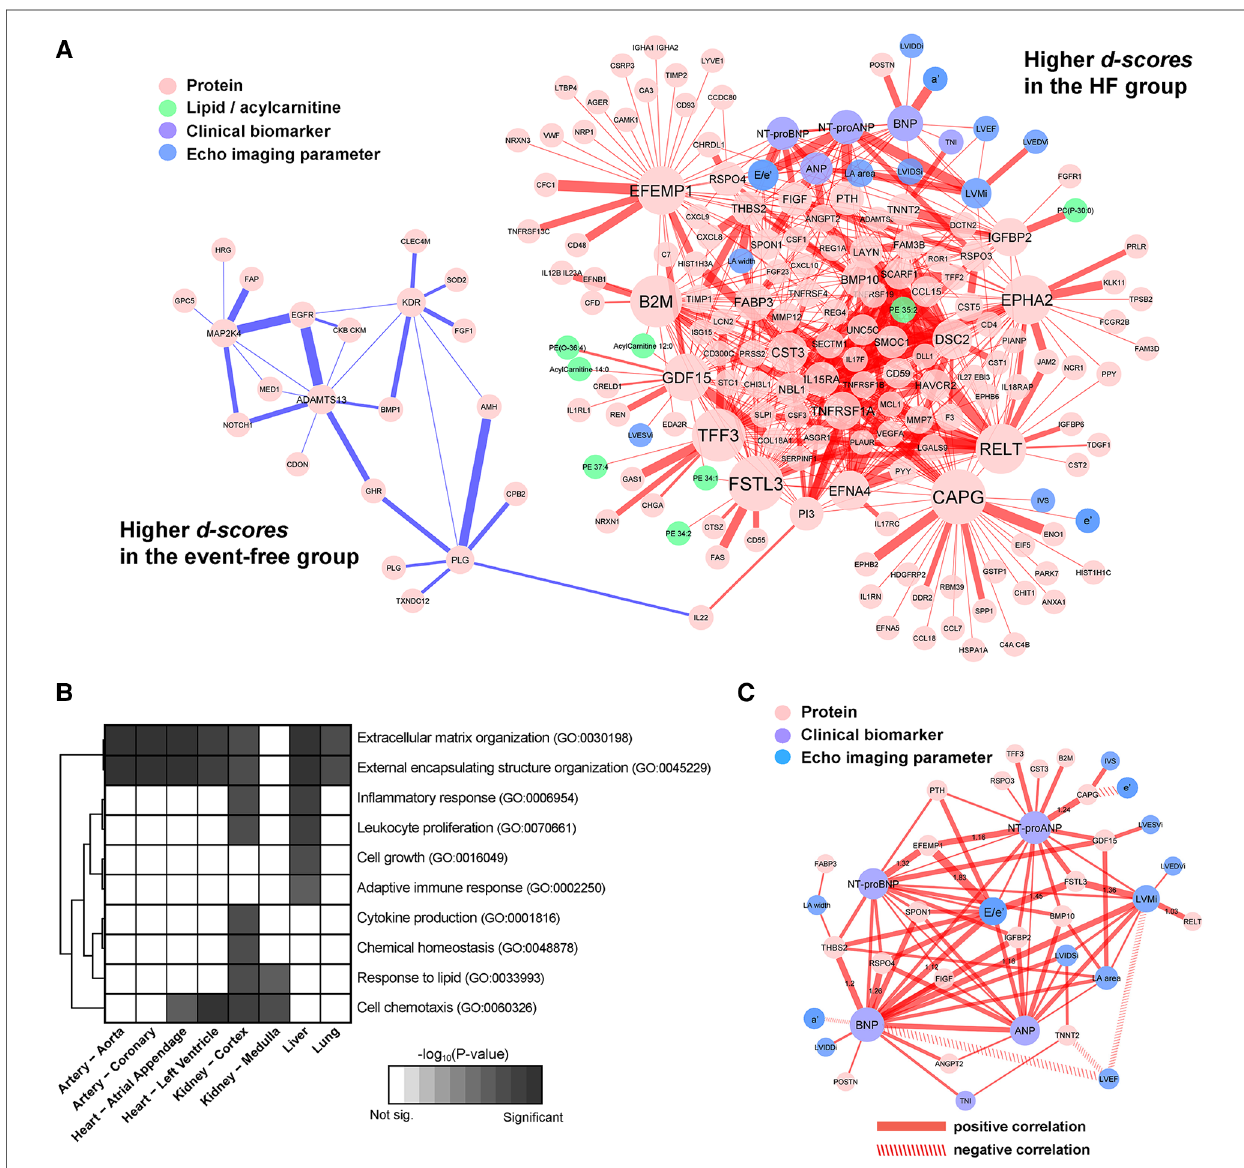
FIGURE 4 Subnetwork signature of HF. ( A ) The edges were colored by the sign of the d-scores for the HF group (positive in red, and negative in blue, respectively). The thickness of edges re fl ects the magnitude of the scores. ( B ) Enrichment of biological functions in the constituent nodes in the panel ( A ) accounting for tissue-speci fi c expression of genes at the mRNA level. ( C ) A subset of the HF signatures consisting of fi rst-degree neighbors of echocardiographic variables and clinical biomarkers, with line properties of the edges set according to the signs of respective partial correlations (positive in solid, and negative in